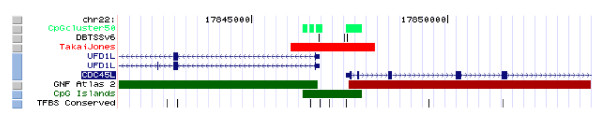
A bidirectional promoter region in human chromosome 22 which is overlapped by one TJ or UCSC island but by several CpGcluster islands. The two genes show very different expression profiles, and therefore it is very likely that the prediction of different islands for the different TSSs as done by CpGcluster is the better choice. The figure was obtained by using the UCSC Genome Browser [46].